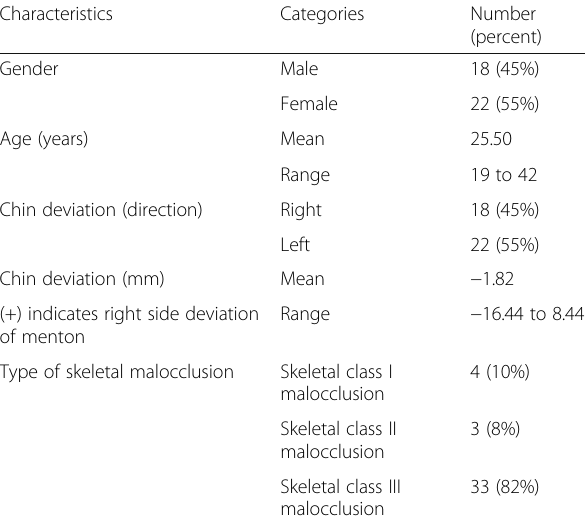
Table 4 Patients characteristics ( N = 40).